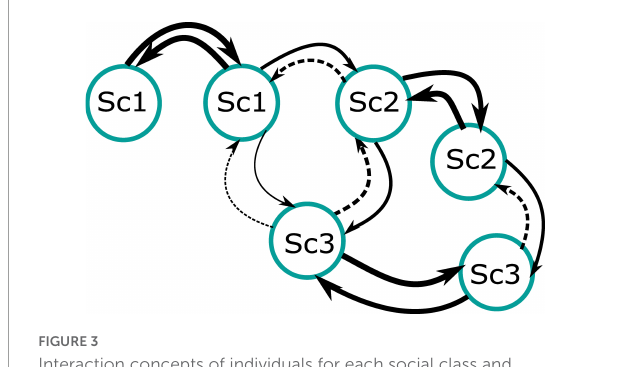
FIGURE3 Interaction concepts of individuals for each social class and social-mixing types are implemented in the model. Sc1, upper-classes; Sc2, medium classes; and Sc3, lower classes. Each class has stronger interactions within their classes, while intra-classes have less strong interactions. The arrow’s thickness shows the relative strength of the interaction, with dashed arrows representing weaker